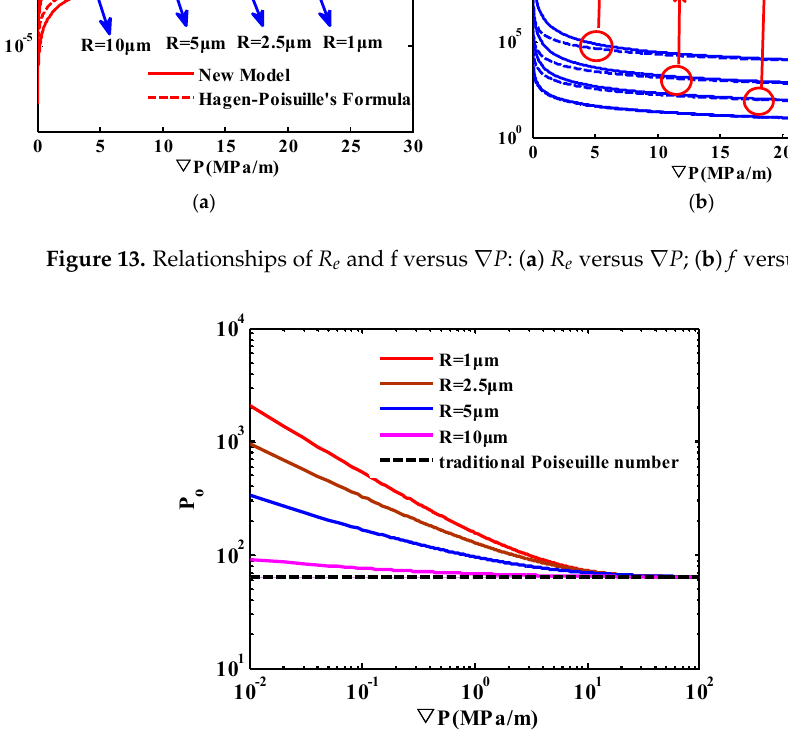
Energies 2018 , 11 , x FOR PEER REVIEW 15 of 21